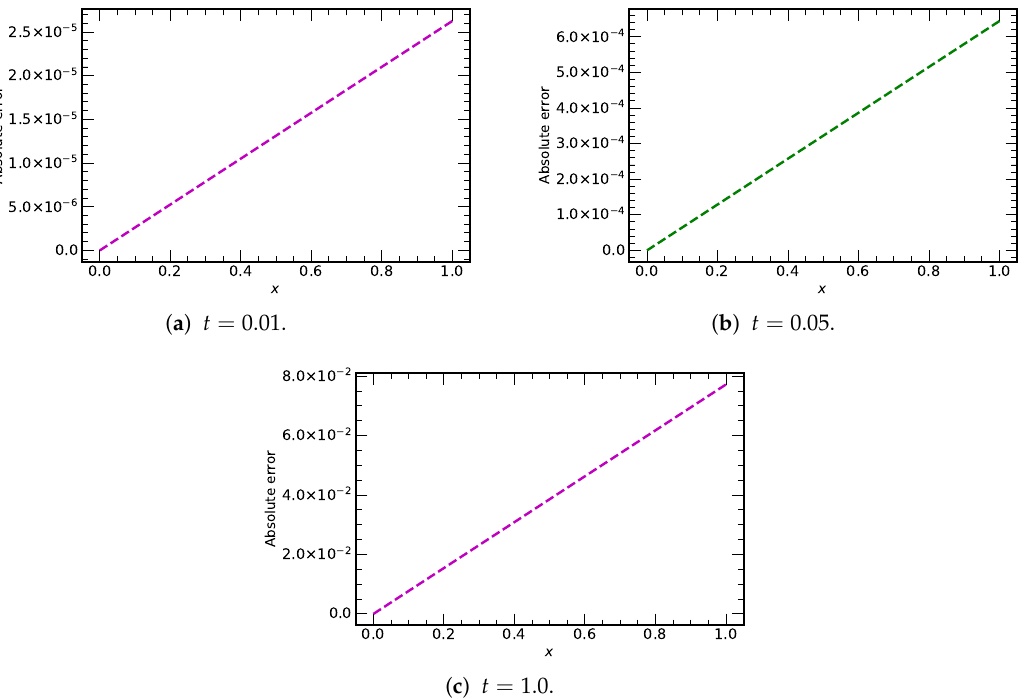
Figure 16. Plots of absolute errors vs. x using 5-terms of BALDM at different values of time ( t =